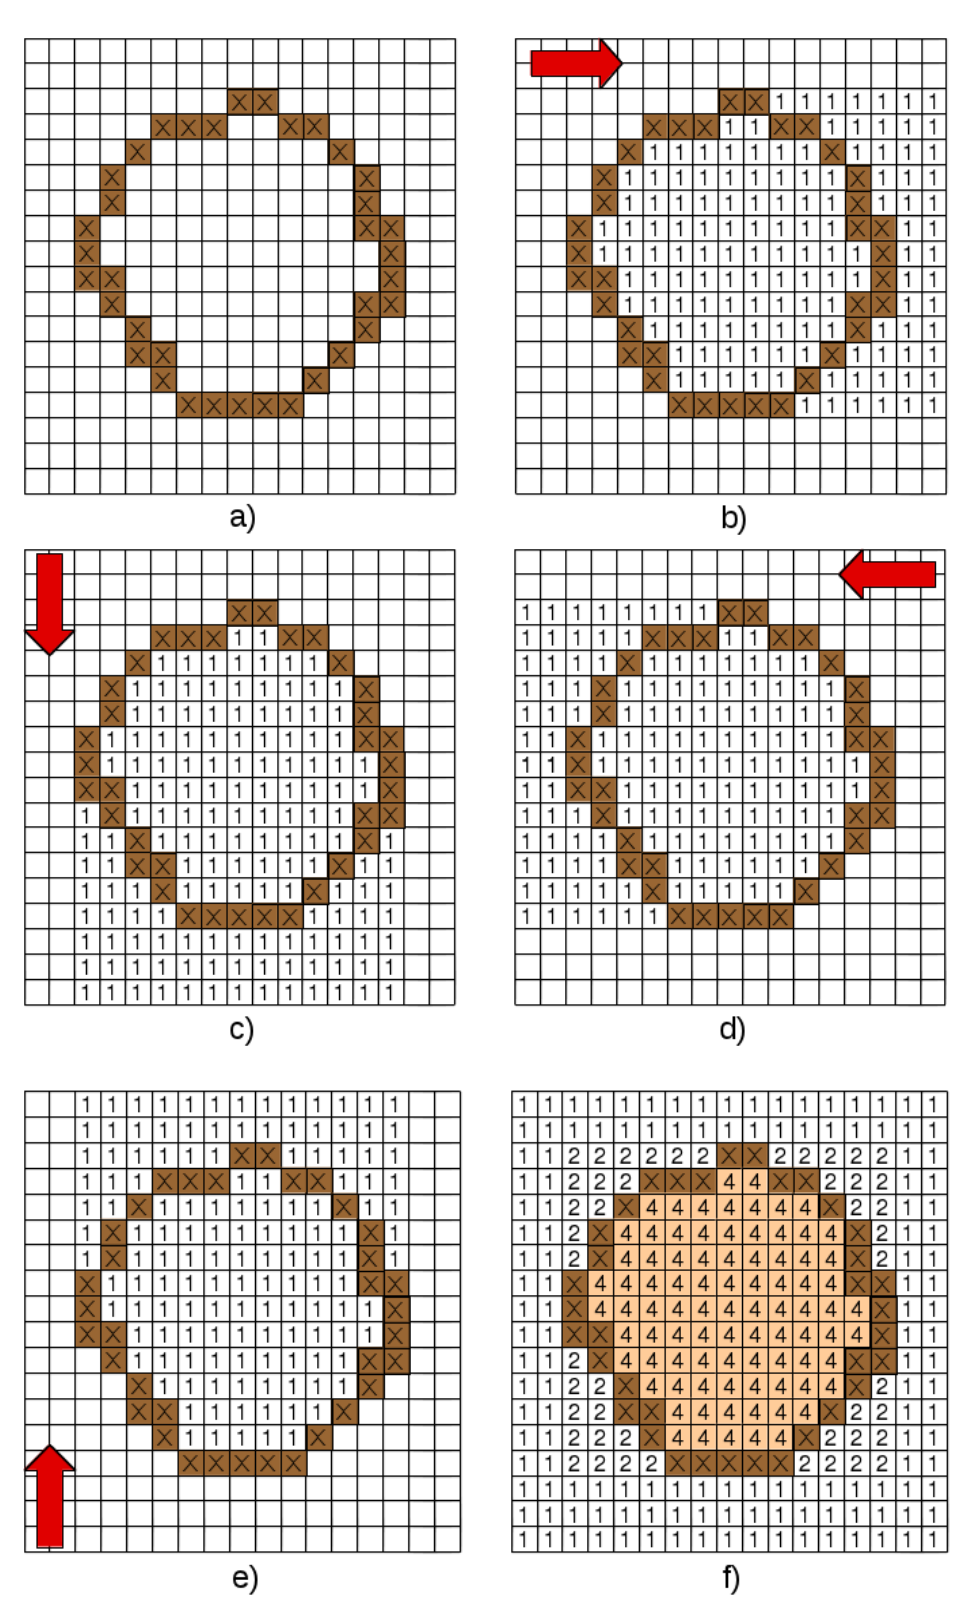
Figure 1. Principle of filling process, a) Original surface voxels of a horizontal layer, b) – e) Marking of voxels of obstructed vision in four orthogonal directions, f) Intersection result of the four areas of obstructed vision, only voxels containing value v=4 are filled voxels for volume